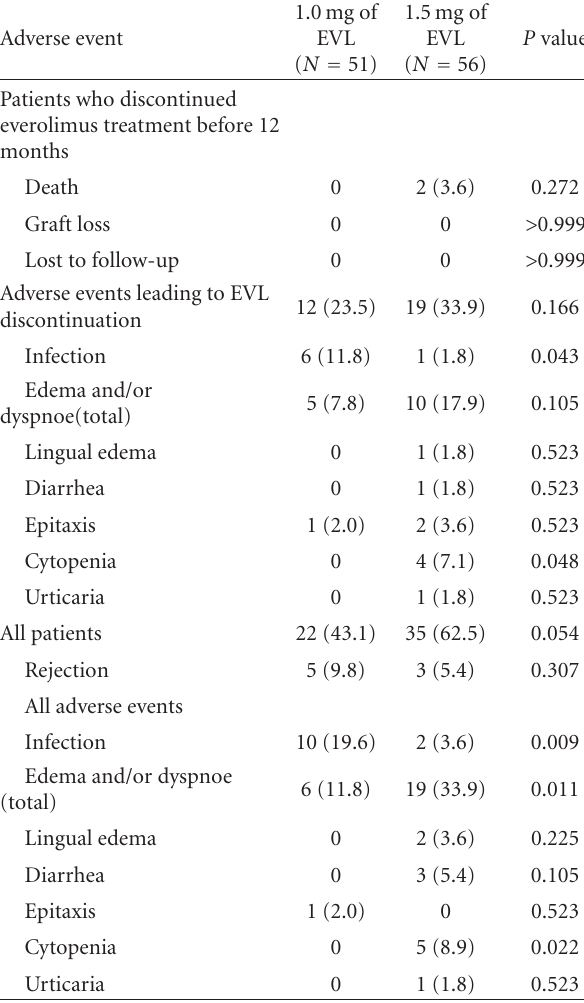
1 Data are presented as numbers and percentages.